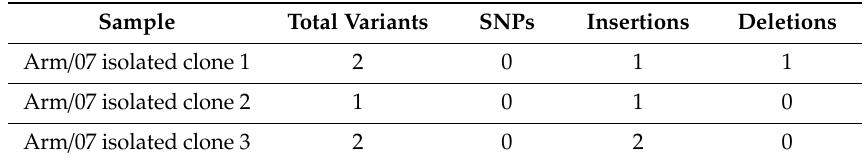
Table 5. Variant analysis of DNA samples of ASFV clones isolated from the Arm / 07 stock compared to Arm / 07 / CBM / c2 genome.